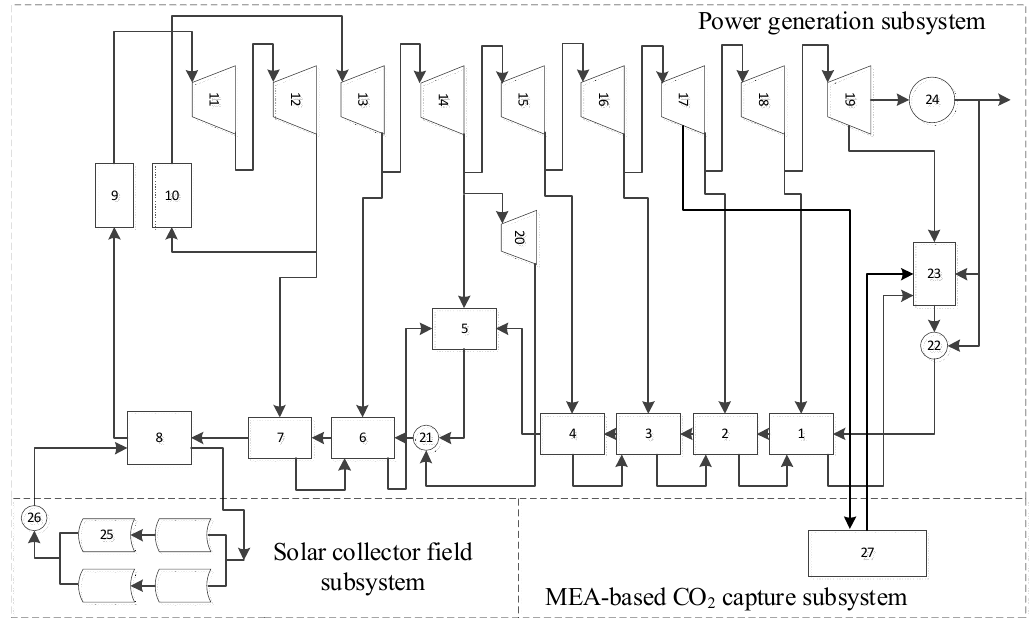
Figure 4. Physical structure of the solar-aided coal-fired power generation with CO 2 capture (SA-PG-CC) system.